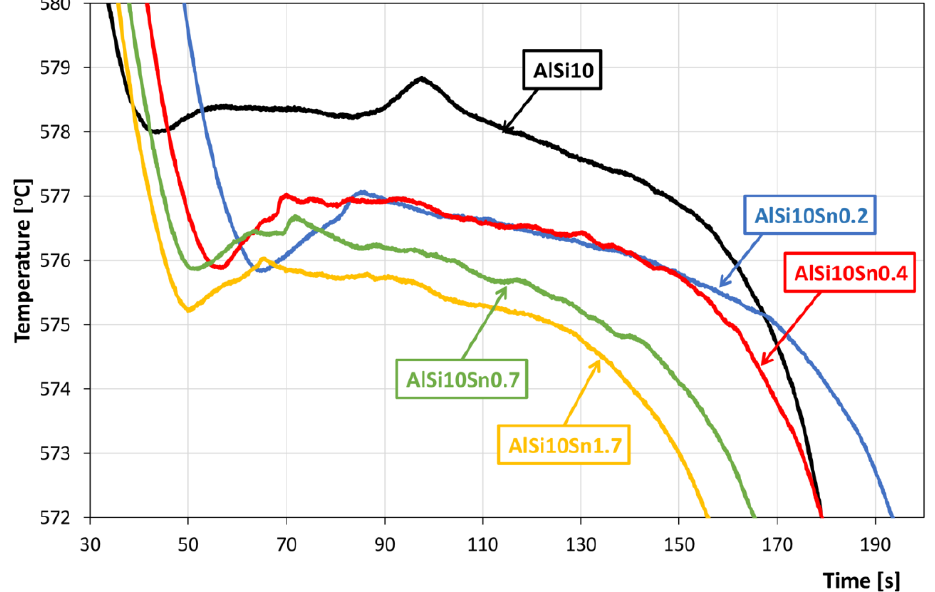
Figure 3. Part of AlSi10Sn alloy’s cooling curve diagram in terms of the onset of solidification of α + β eutectic.